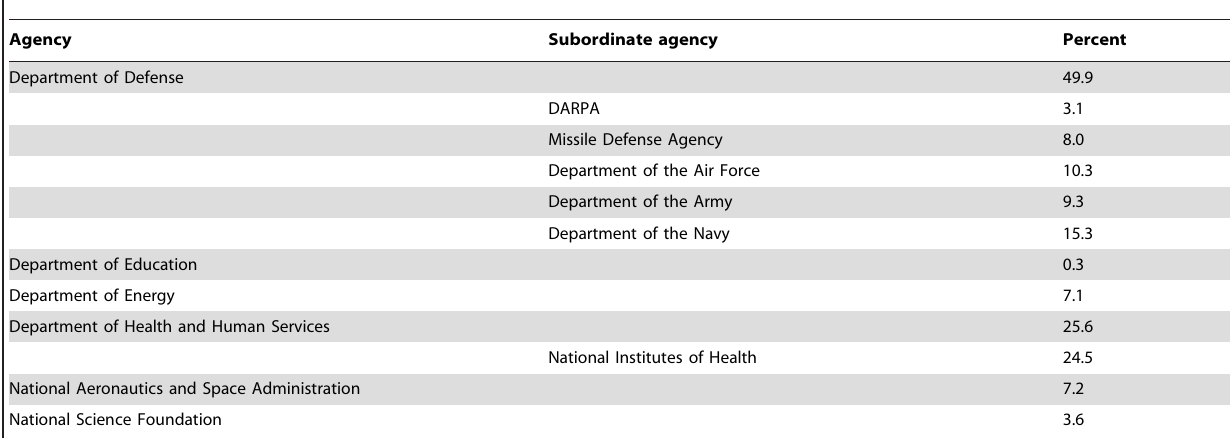
Table 3. Breakdown of federal spending on R&D in